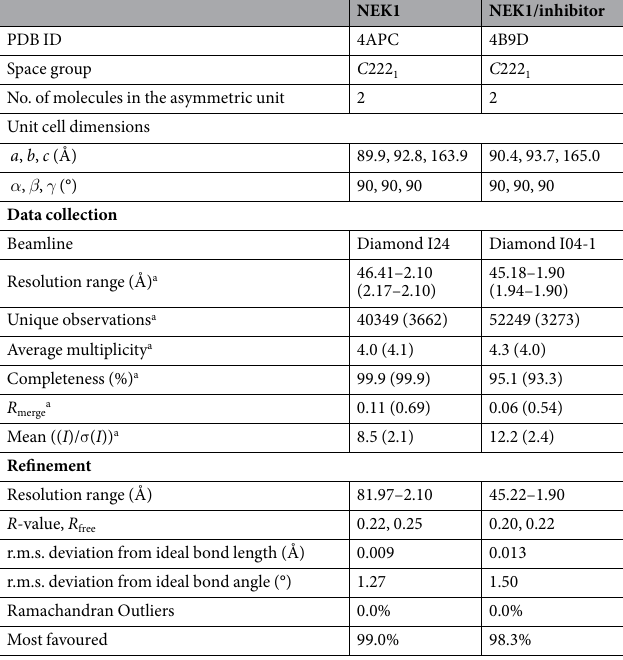
Table 1. Data collection and refinement statistics. a Values within parentheses refer to the highest resolution shell. b Values from Molprobity 78